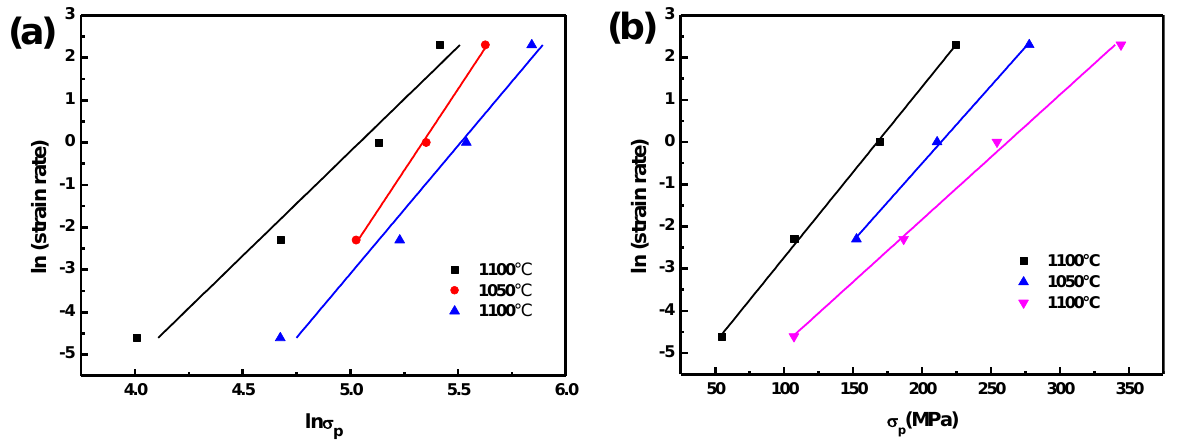
. ε and ( a ) ln σ p ; ( b ) σ p